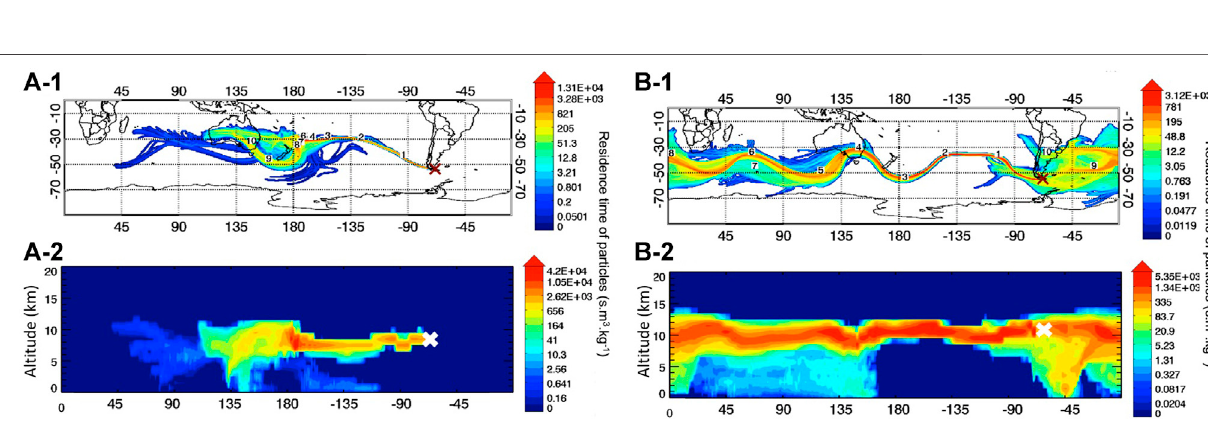
FIGURE 1 | Airborne CO (blue) in situ observations and respective altitude information (black) on November 12th 2019 at around 57 ° S and 67 ° W. The two vertical lines (a, b) indicate initialization times for back trajectory calculations ( Figure 2 ).